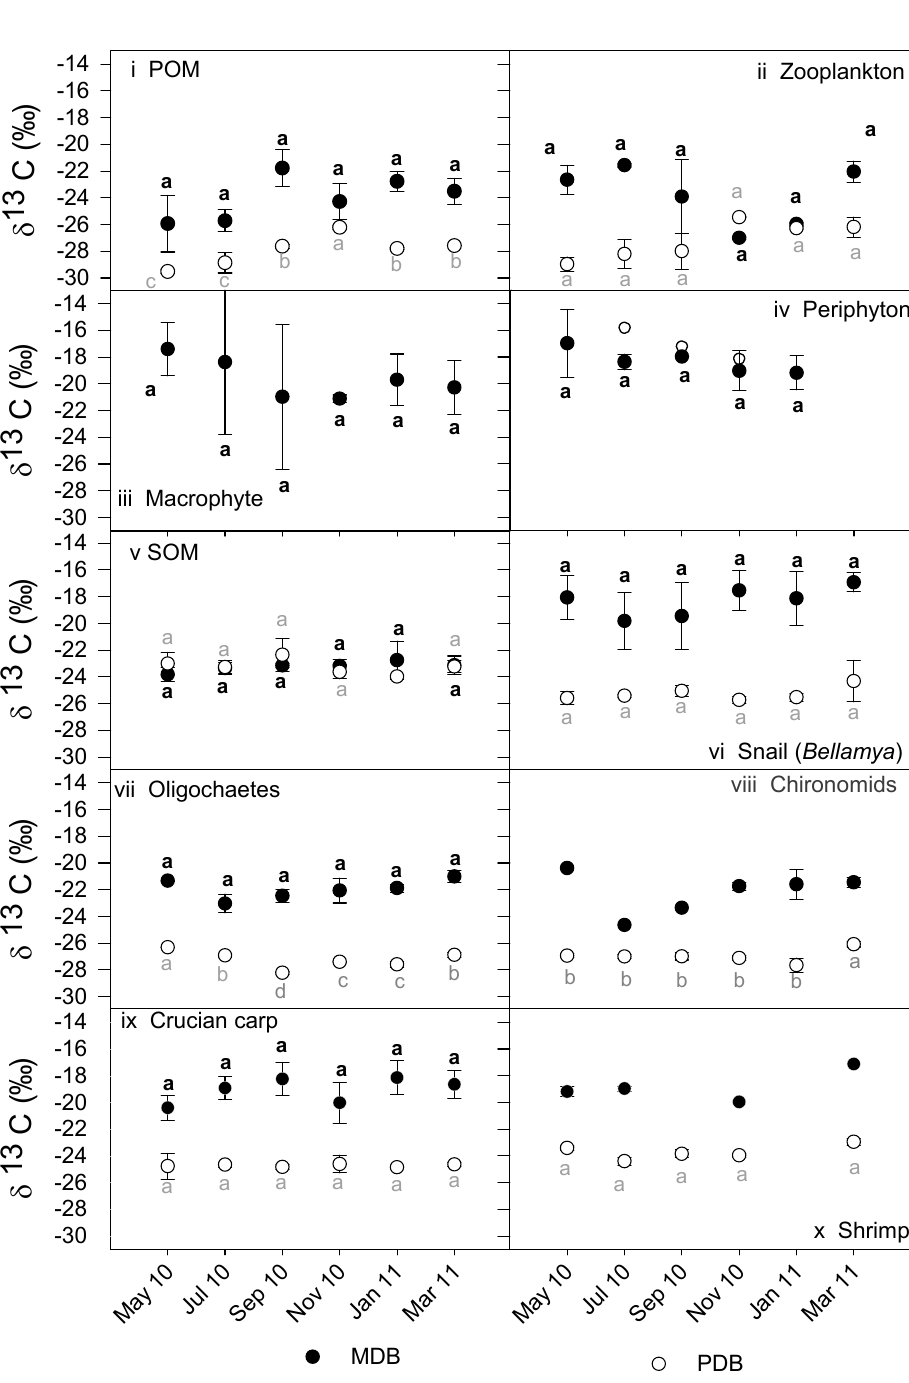
Figure 4. Repeated measures of δ 13 C (‰) in food sources, invertebrates, and fish in MDB and PDB during the period April 2010 to March 2011. Gray and bold letters show the results of seasonal variation analysis using Bonferroni’s Multiple Comparison Test in PDB and MDB.